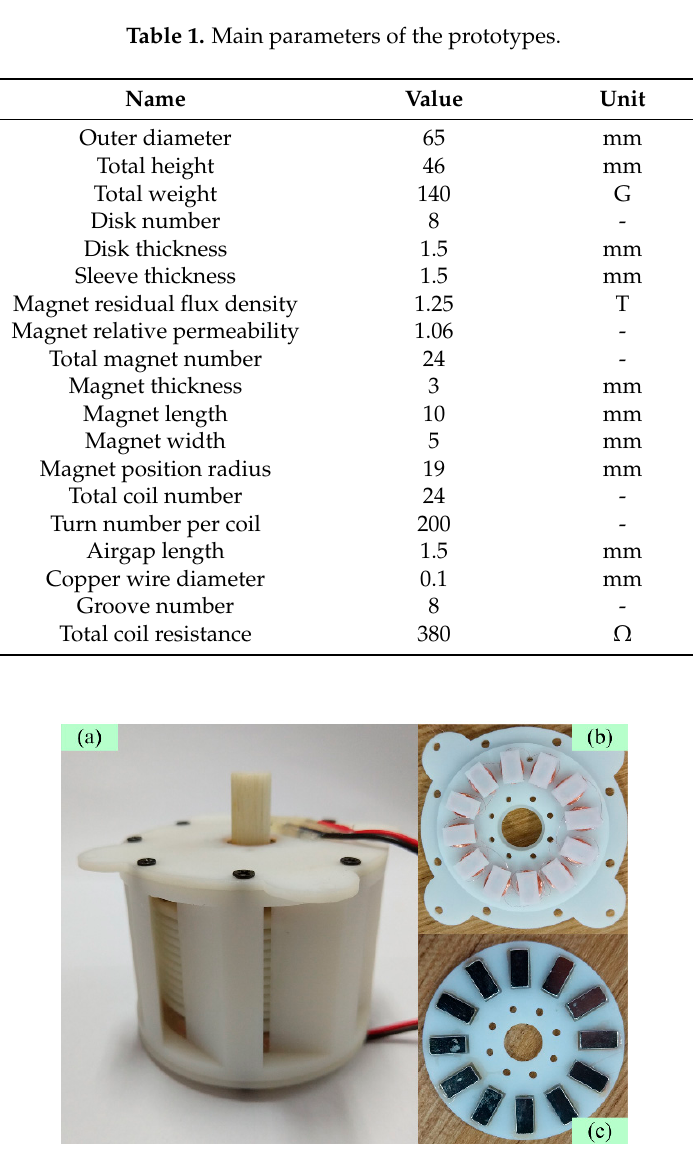
Figure 9. Induced electromotive force of prototypes with different groove angles under no-load condition. Figure 10 presents the comparison between the measured waveform and the analytical waveform of the induced electromotive force at the rotation speed of about 500 rpm. It can be observed that the two waveforms are in good accordance on the whole. The waveforms are almost sinusoidal because of the distributions of the coils and the permanent magnets. Figure 11 shows the peak-to-peak values of induced electromotive force varying with rotation speed. It can be seen that the induced electromotive force is linear with the rotation speed, and the slope is about 0.0238 V/rpm, which is a quantity related with the magnetic flux. The errors between the measured values and the analytical values may be caused in the numerical calculation by splitting the coil area into finite divisions.